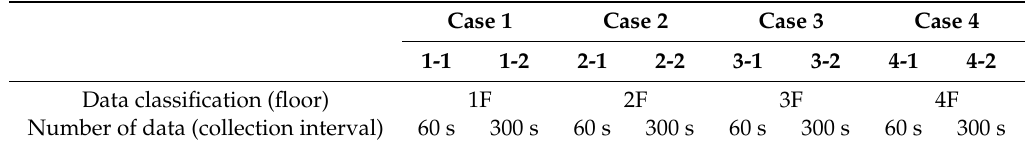
Table 2. ANN models by data characteristics.